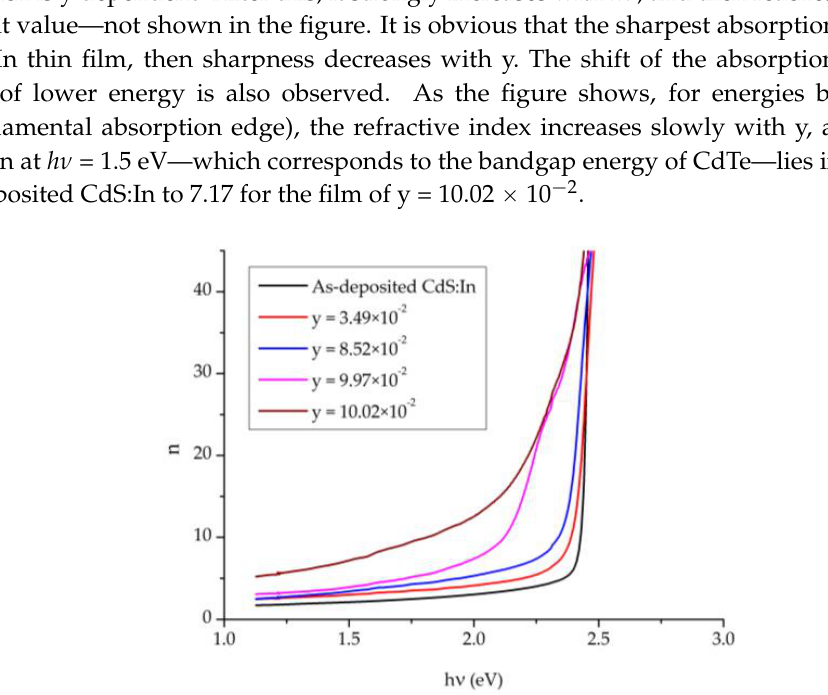
Figure 10. The refractive index of a CdS:In film and CdS 1−y Te y thin films of comparable thickness with different composition y.